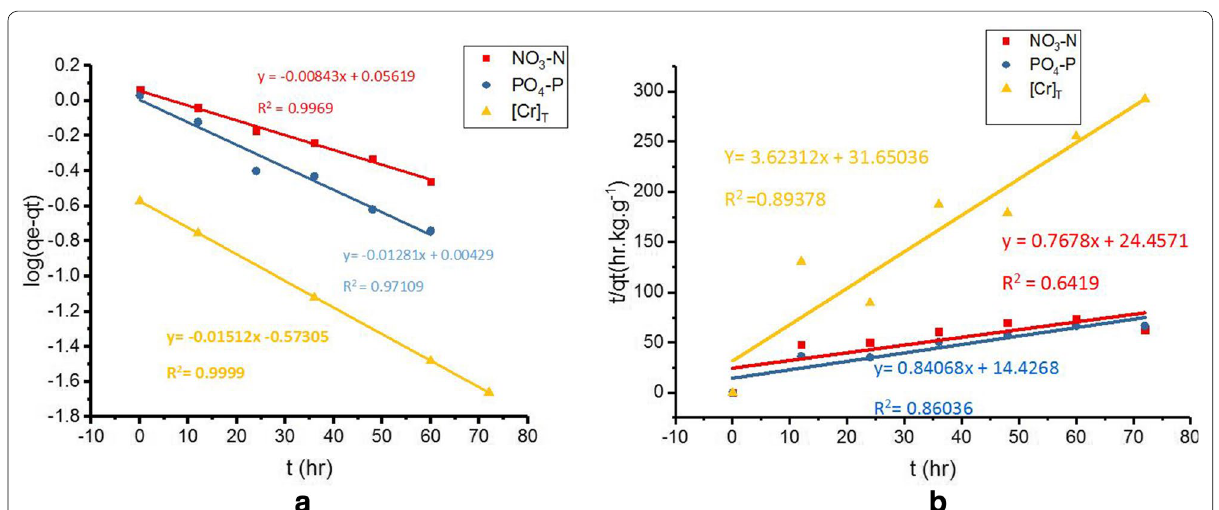
Fig. 5 a Pseudo-first-order and b pseudo-second-order kinetics for the adsorption of NO 3 –N, PO 4 –P and [Cr] T removal onto pumice